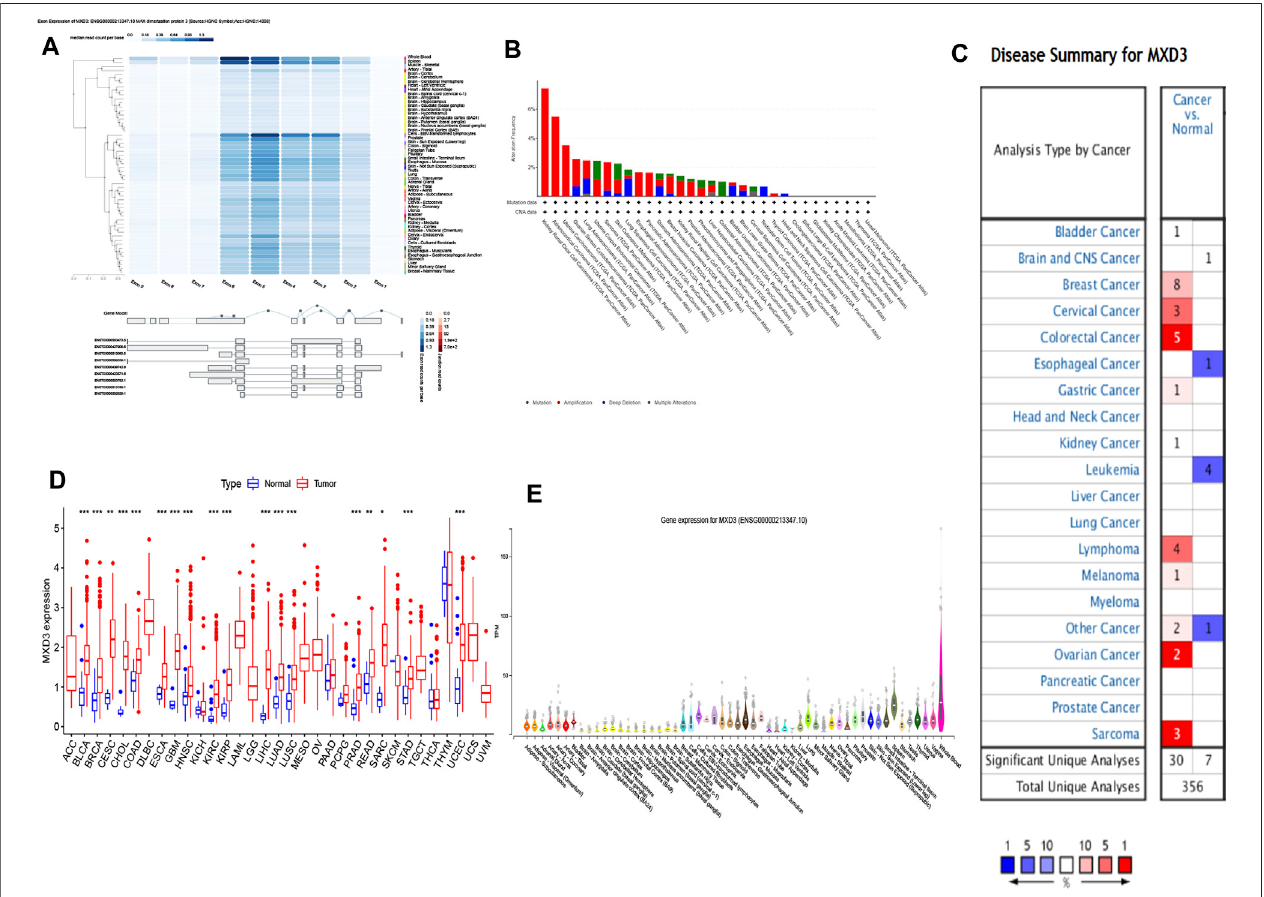
FIGURE 1 | MXD3 expression and mutation of normal and cancer tissues: (A) expression of the MXD3 exon; (B) MXD3 mutation; (C) Oncomine dataset of cancer and paracancerous samples; (D) TCGA dataset of cancer and paracancerous samples; (E) different organs (*** p < 0.001, ** p < 0.01, * p < 0.05).